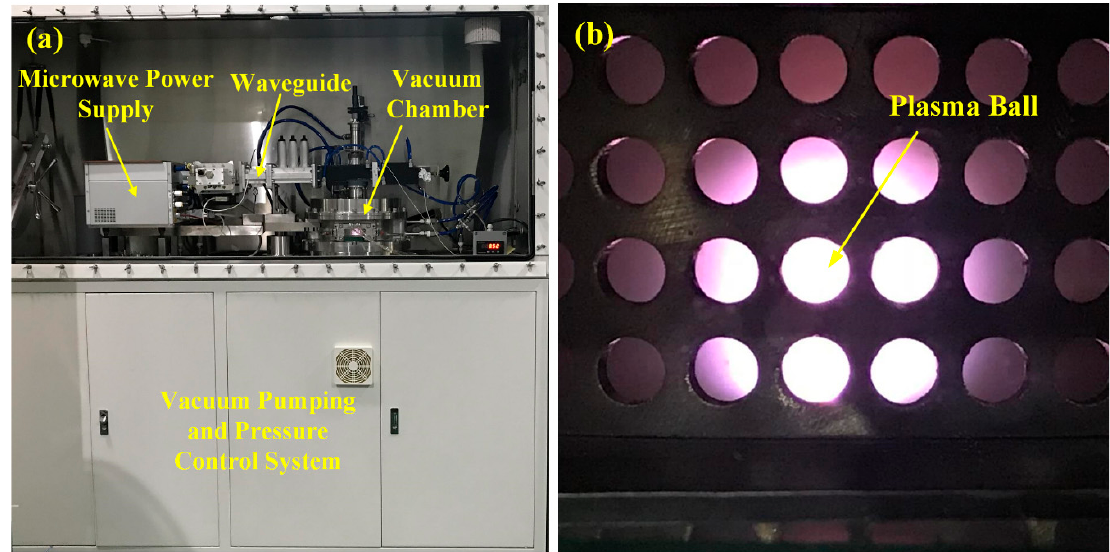
Figure 3. Photographs of the ( a ) newly developed reactor and ( b ) the hydrogen plasma discharge generated by a microwave power of 3 kW and a gas pressure of 130 mbar.